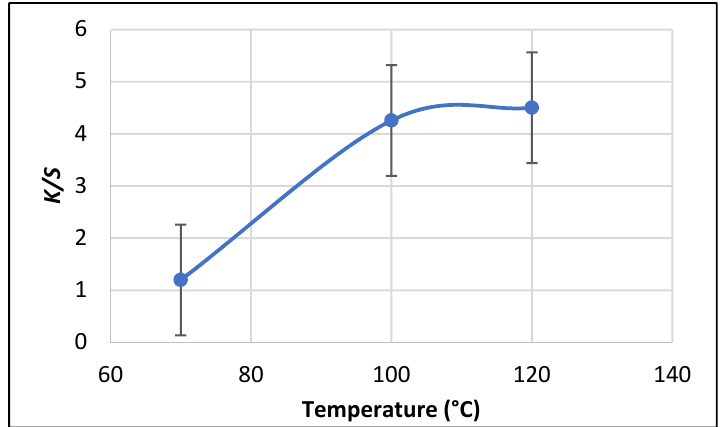
Figure 8. Effect of treatment temperature on color strength (K/S).